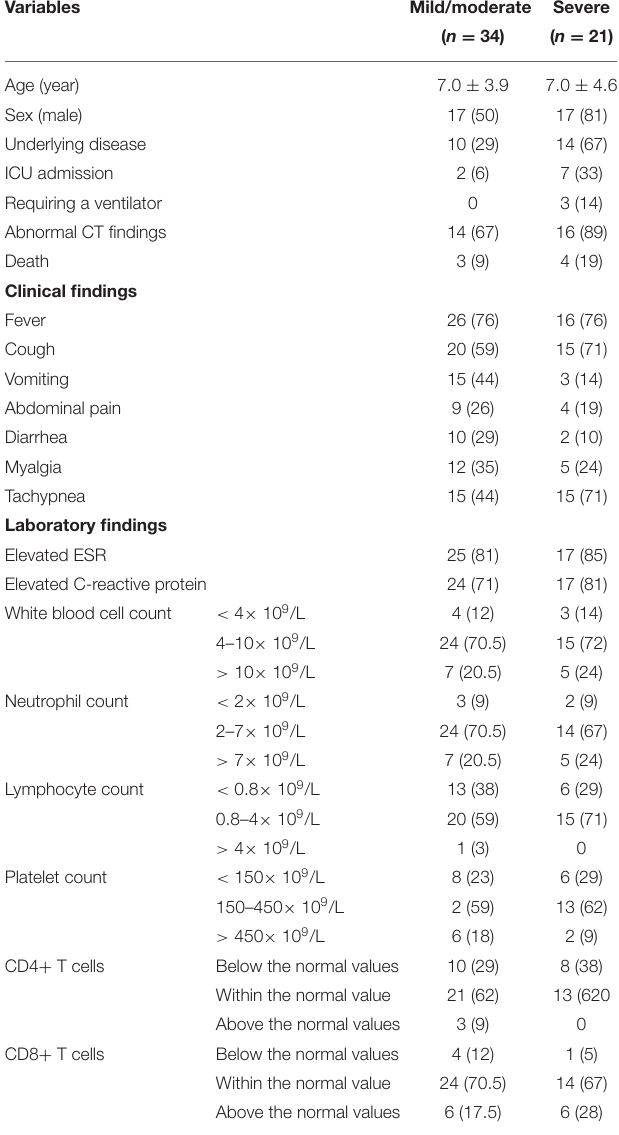
TABLE 1 | Demographic, clinical, laboratory and radiological findings of patients with mild/moderate and severe COVID-19.